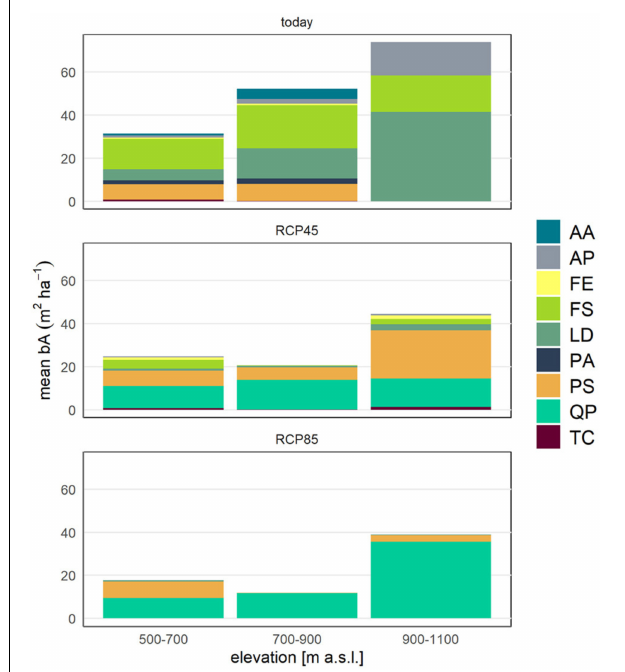
FIGURE 8 | Current (“today”; based on field data) and future (“RCP4.5” and RCP8.5” in 50 years) mean basal area per elevation level and main species. Species abbreviations: AA, Abies alba ; AP, Acer pseudoplatanus ; FE, Fraxinus excelsior ; FS, Fagus sylvatica ; LD, Larix decidua ; PA, Picea abies ; PS, Pinus sylvestris ; QP, Quercus pubescens ; TC, Tilia cordata .